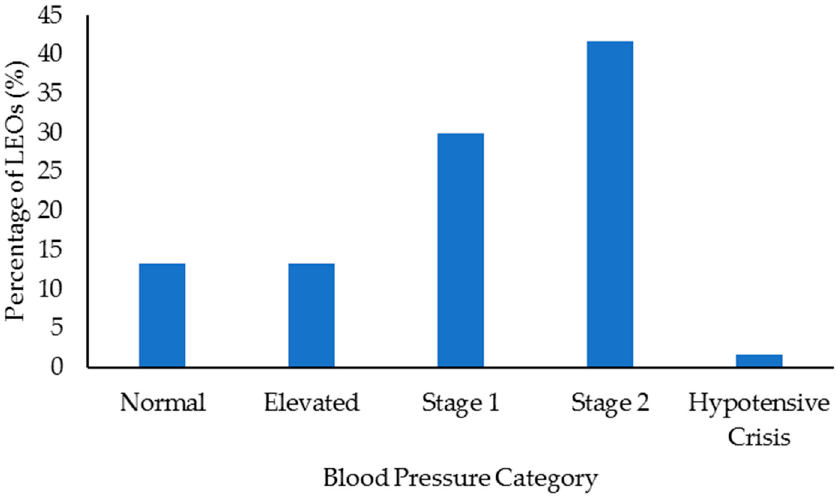
Figure 5. Percentage of law enforcement officers (LEOs) in this sample ( n = 60) classified according to the blood pressure standards.